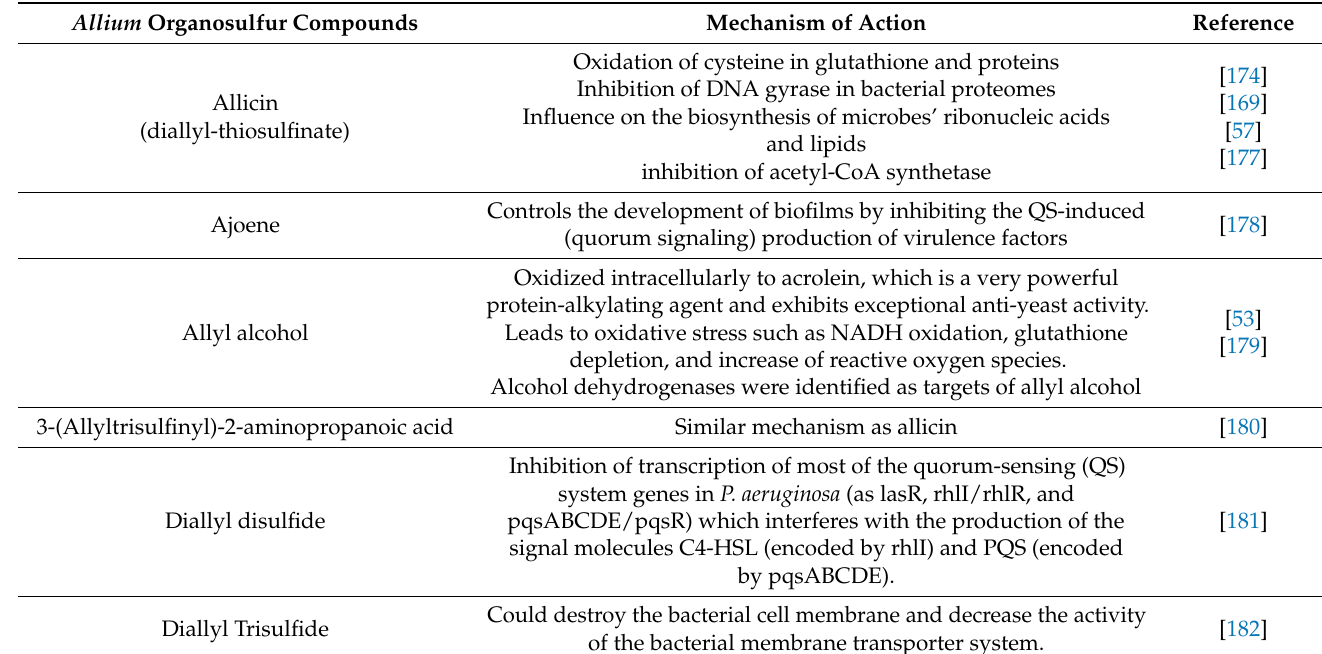
Table 3. The most abundant organosulfur compounds in Allium species and their mechanism of antimicrobial